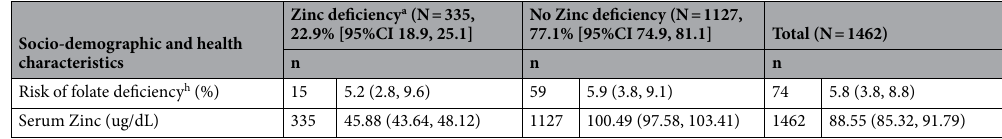
Table 1. Socio-demographic and health characteristics of children aged 6 to 59 months by the status of zinc deficiency, Nepal National Micronutrient Status Survey, Nepal, 2016. Ns are unweighted. Values presented are mean(95%CI) or percent(95%CI). All estimates account for weighting and complex sampling design. AGP ɑ -1 acid glycoprotein, CI confidence interval, CRP C-reactive protein, RBC red blood cell, RBP retinol- binding protein. a Zinc deficiency defined as serum zinc < 65.0 μg/ dL for nonfasted, morning (i. e. before 12 pm) samples and < 57.0 μg/ dL for non-fasted, afternoon (i. e. after 12 p.m.) samples, inflammation adjusted 38 . b Hemoglobin adjusted for altitude and smoking 39 . c Anemia defined as altitude-and smoking- adjusted Hb < 12.0 g/dL 39 . d Soil-transmitted helminths including hookworm, Trichuris trichura, and Ascaris lumbricodes. e Biomarker was regression-adjusted to a pooled country reference to adjust for inflammation, using CRP and AGP (ferritin) or AGP only 40 . f Iron deficiency defined as inflammation-adjusted serum ferritin < 15.0 μg/L 39 . g Vitamin A deficiency was defined as RBP < 0.64 μmol/ L. h Folate cut off based on the risk of megaloblastic anemia defined as RBC folate < 305.0 nmol/L 41 .